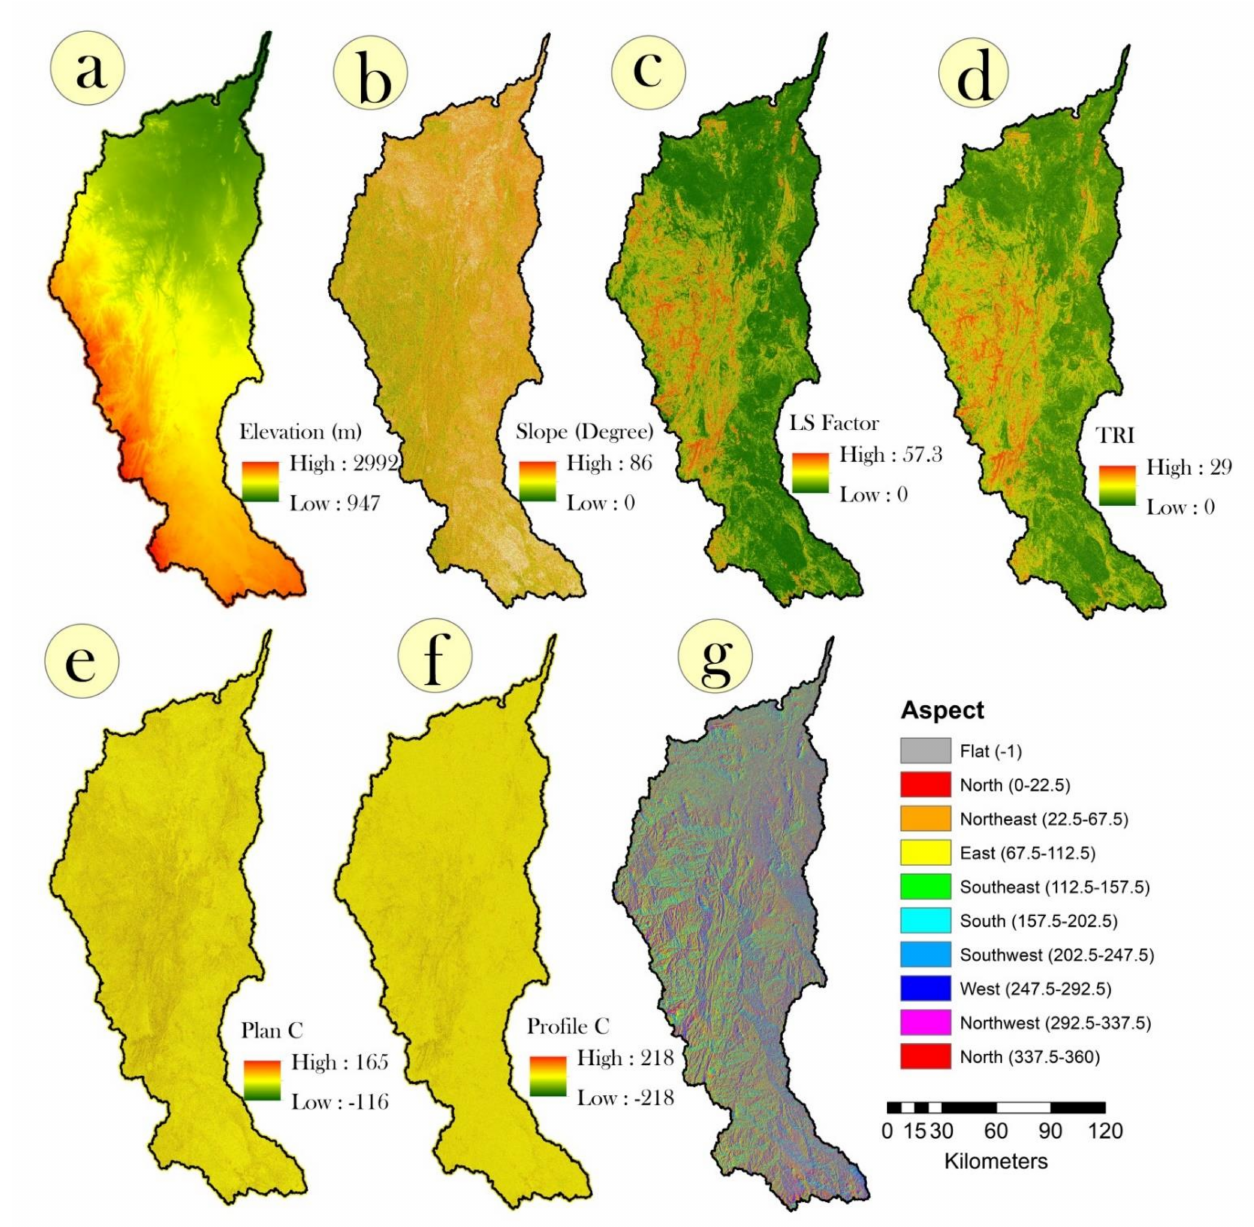
Figure 2. DEM derived topographic parameters, such as ( a ) elevation, ( b ) slope, ( c ) LS Factor, ( d ) TRI, ( e ) plan curvature, ( f ) profile curvature, and ( g )